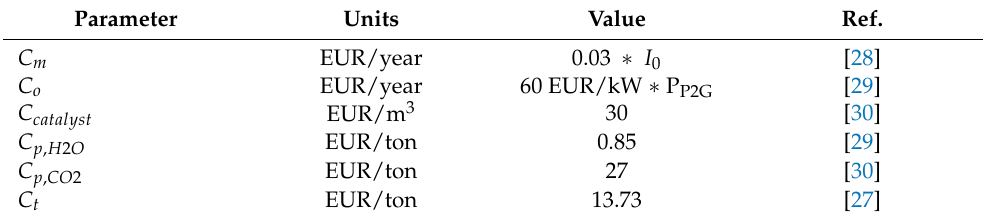
Table 2. Operation and maintenance